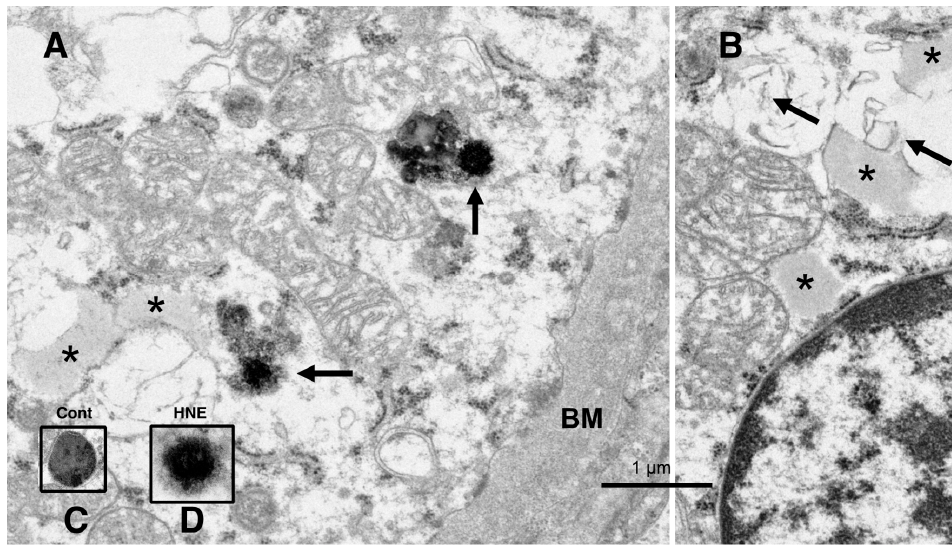
Figure 8. Electron microphotographs of the degenerating hepatocytes after the hydroxynonenal (HNE) injections. Compared to the membrane-bound, vivid lysosomes ( C ) in the control hepatocytes,